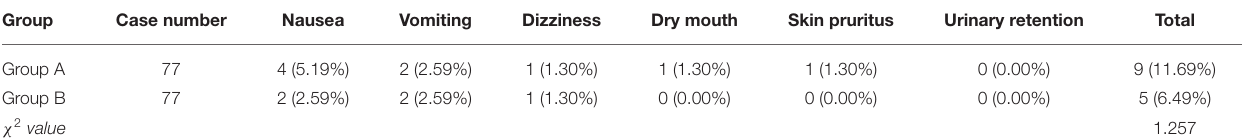
TABLE 2 | Comparison of adverse reactions between two groups.